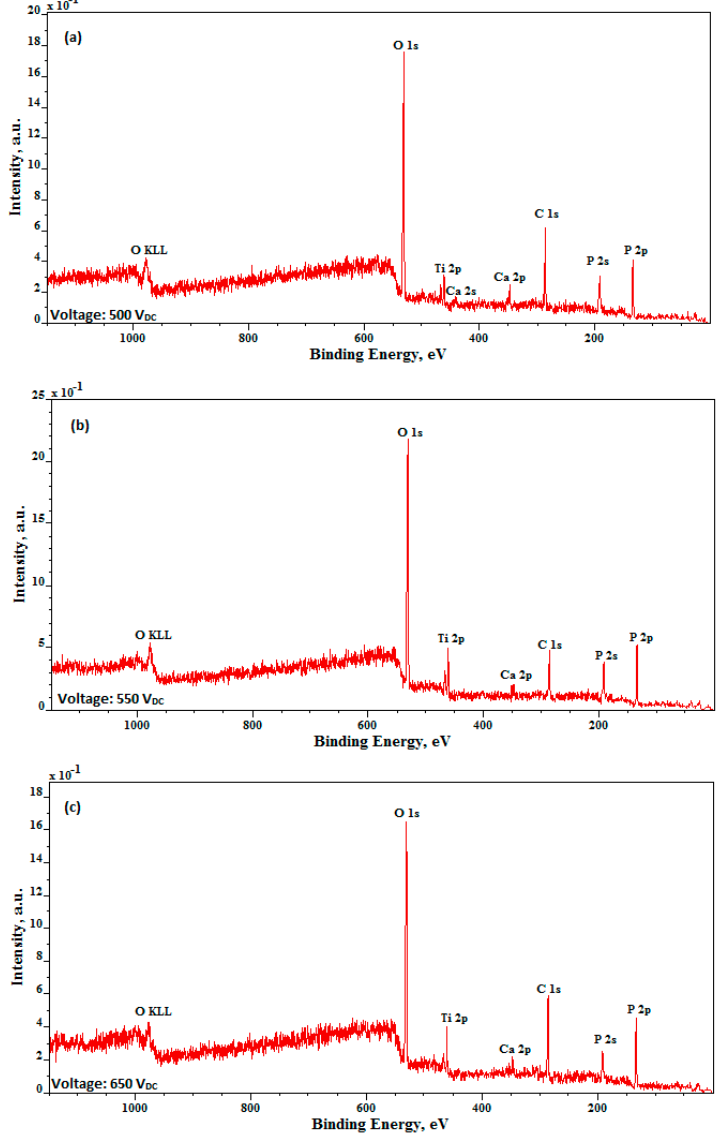
Figure 9. X-ray Photoelectron Spectroscopy (XPS) spectra of porous coatings formed on CP Titanium Grade 2 after PEO treatment at voltages of ( a ) 500 V DC , ( b ) 550 V DC , ( c ) 650 V DC , in 500 g Ca(NO 3 ) 2 ·4H 2 O in 1000 mL H 3 PO 4 electrolyte.